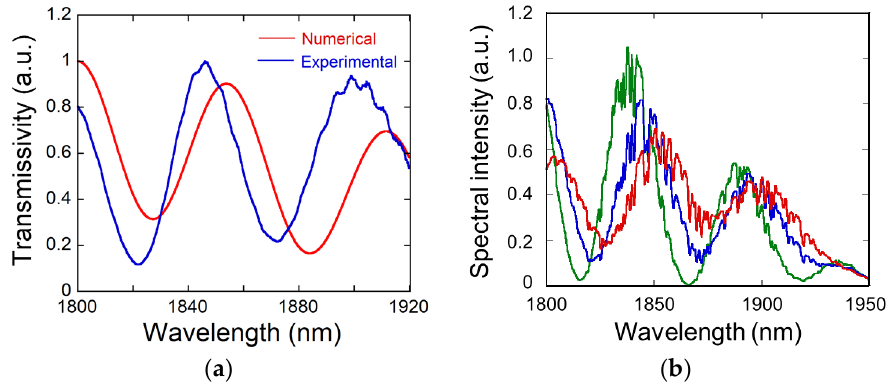
Figure 3. Wavelength dependence of developed tunable filter, ( a ) comparison of numerical and experimental transmission spectra, and ( b ) variation of transmitted spectra during the wavelength tuning operation.